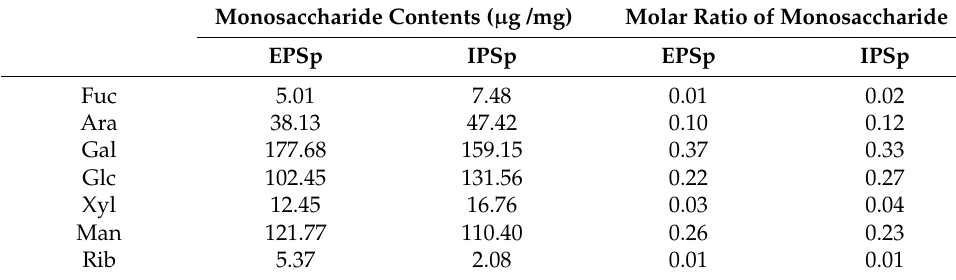
Table 2. Monosaccharide contents and molar ratios of EPSp and